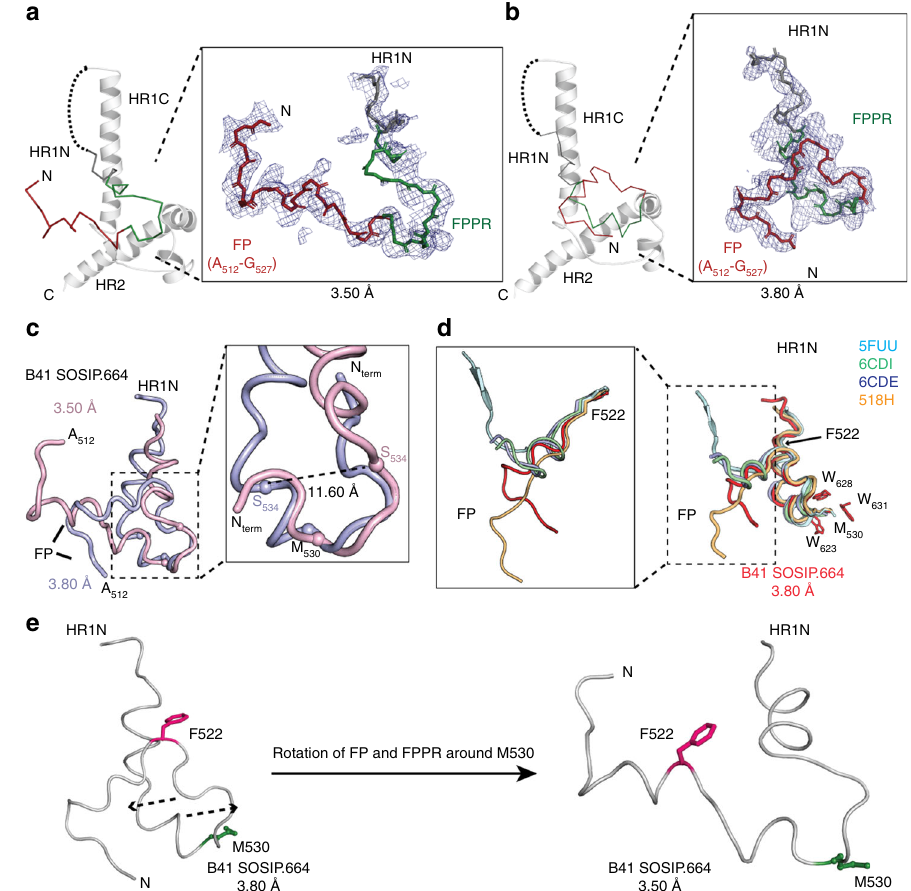
Fig. 2 Different conformational states of the fusion peptide in B41 SOSIP.664. a The FP (red) of gp41 at 3.50 Å points away from HR2. Inset shows the 2Fo – Fc electron density composite omit maps (1.0 σ ) for the fusion peptide (residues 512 – 527, red), and FPPR (residues 528 – 540, green). b The FP from the 3.80 Å structure extends towards HR2. Inset shows the 2Fo – Fc electron density map (1.0 σ ) for the FP and FPPR. c Overlay of FP and FPPR regions of gp41 from the two crystal structures (3.50 Å: light pink, 3.80 Å: light blue). Inset illustrates the large rearrangement of FPPR and major C α displacement for example of S534 (~11.6 Å) in B41 SOSIP.664 following the same resolution-based color-code. d Different conformational states of FP illustrated in the overlay of the FP, FPPR, and HR1N regions of PGT151-bound WT JRFL Δ CT (PDB ID: 5FUU; cyan), vFP16-bound BG505 DS-SOSIP (PDB ID: 6CDI; green), vFP20-bound BG505 DS-SOSIP (PDB ID: 6CDE; blue), and VRC34.01-bound BG505 SOSIP.664 (PDB ID: 5I8H; orange), recognized by the